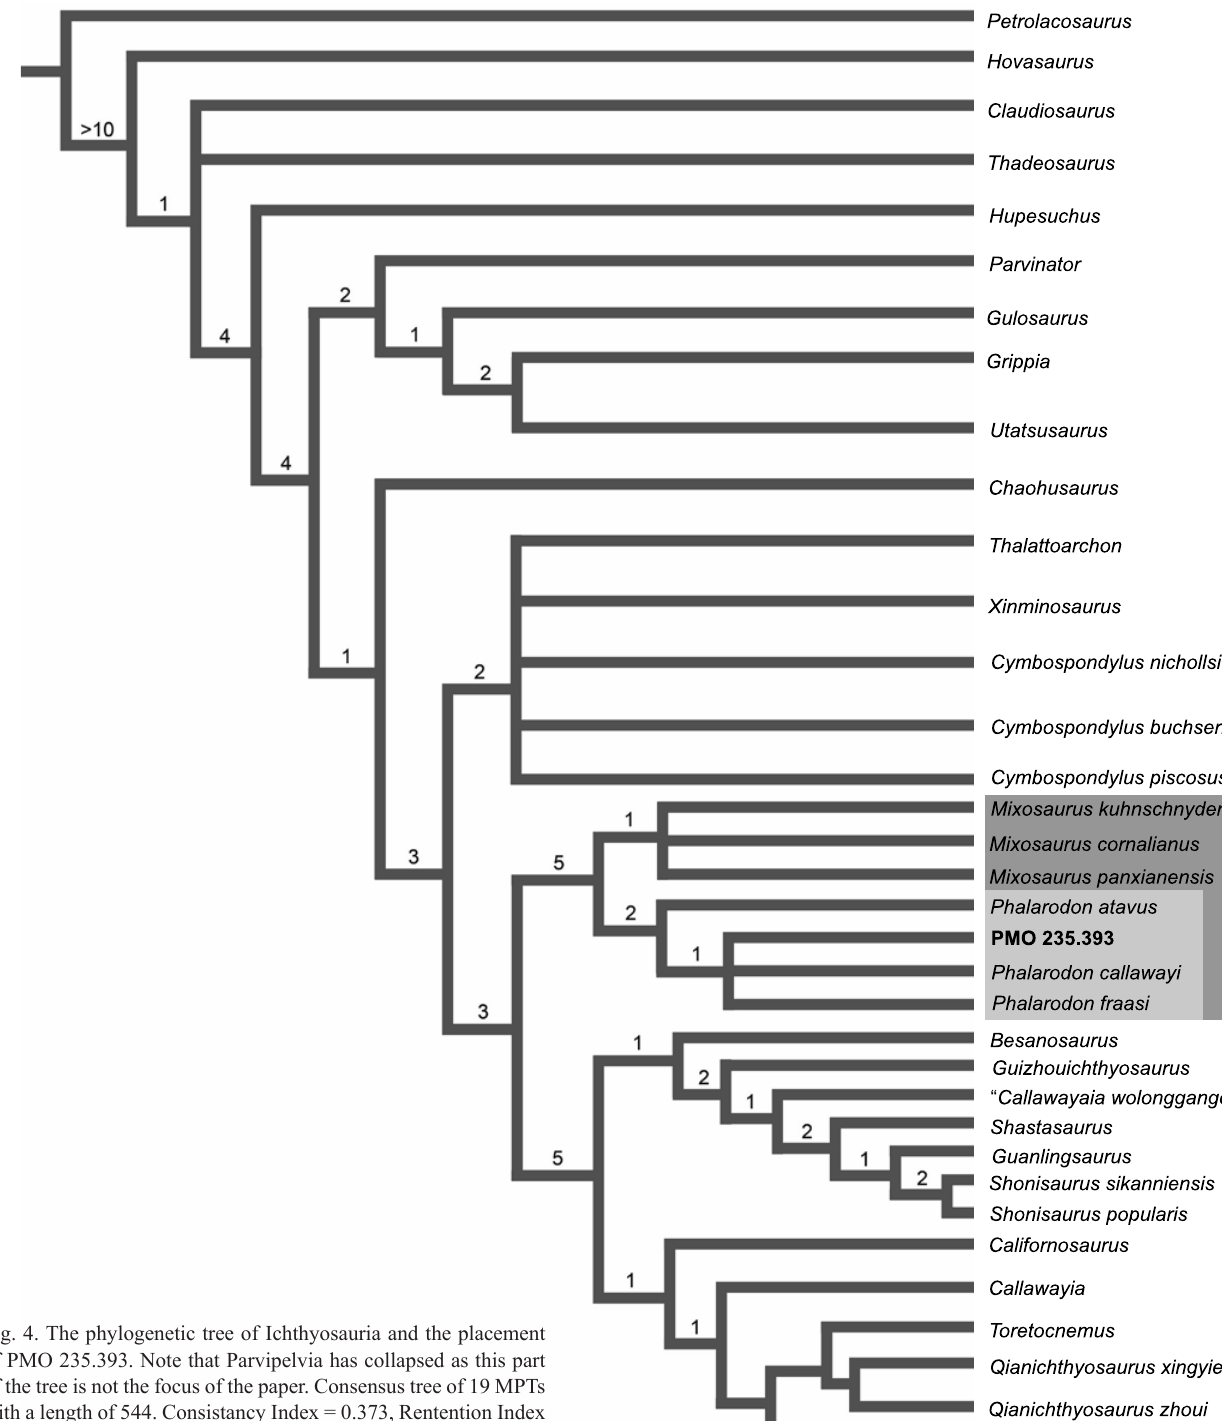
Fig. 4. The phylogenetic tree of Ichthyosauria and the placement of PMO 235.393. Note that Parvipelvia has collapsed as this part of the tree is not the focus of the paper. Consensus tree of 19 MPTs with a length of 544. Consistancy Index = 0.373, Rentention Index = 0.778. Bremer support values displayed above